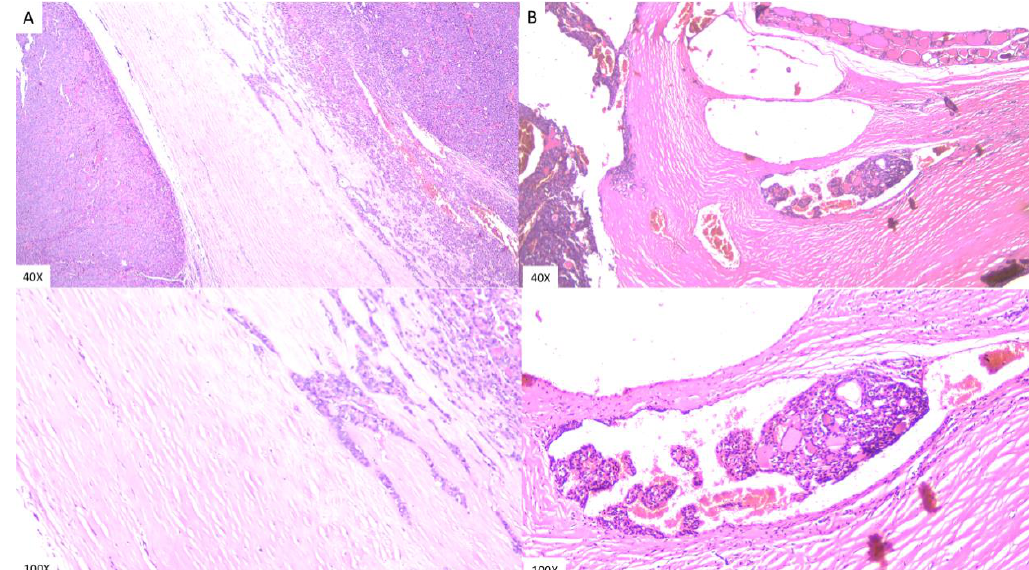
Figure 3. Histology examination revealed that the tumor was arranged in variably-sized follicles containing colloid with capsular invasion ( A ) and vascular infiltration ( B ). The cancer cells consisted of polymorphic cells with nuclear enlargement and